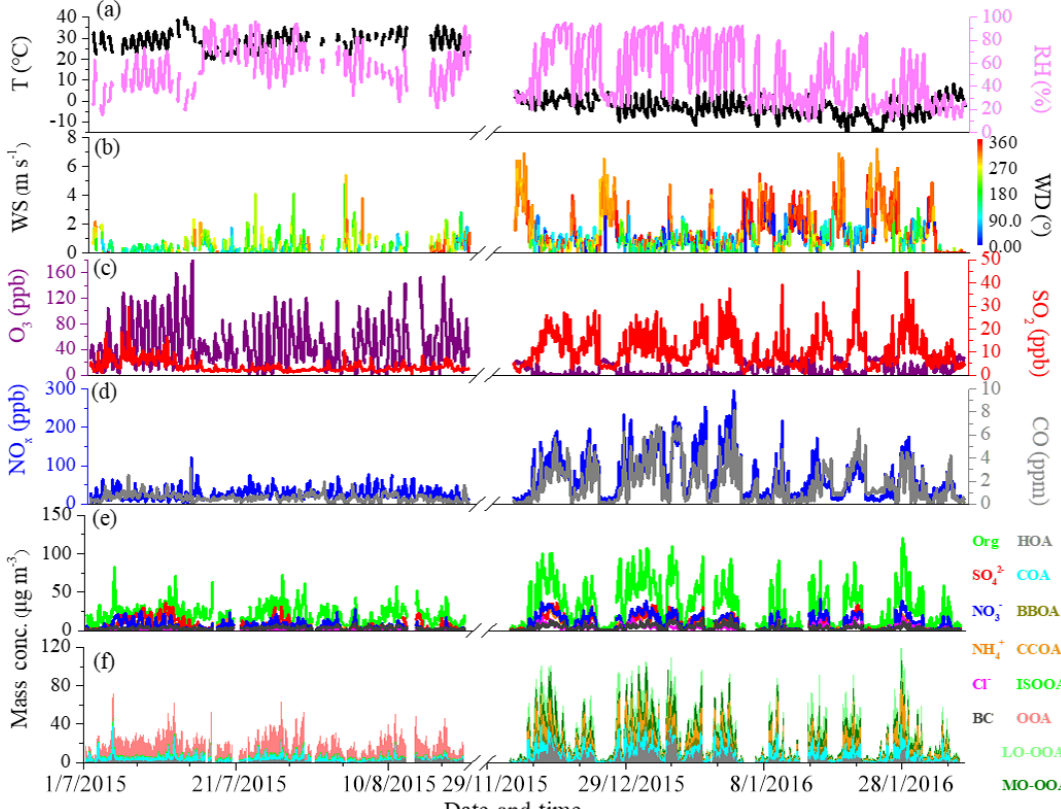
Figure 1. Time series of (a) temperature ( T ) and relative humidity (RH), (b) wind speed (WS) and wind direction (WD), (c) O 3 and SO 2 , (d) CO and NO x , (e) PM 1 species, and (f) OA sources between summer and winter